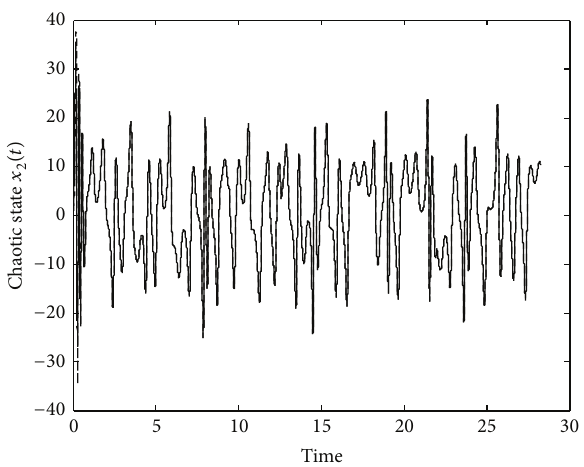
Figure 6: Actual carrier signal 𝑎 (dashed line) and decrypted carrier signal ̂𝑎 (solid line) when 𝑟 = 1